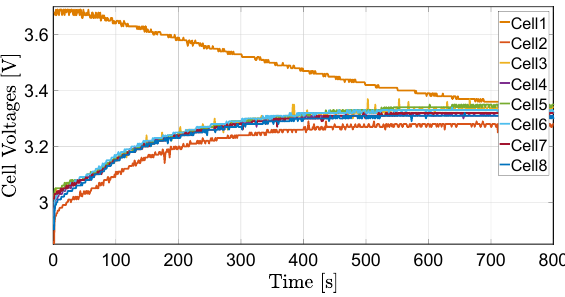
Figure 18. The cell voltage waveforms of the proposed circuit in closer view.